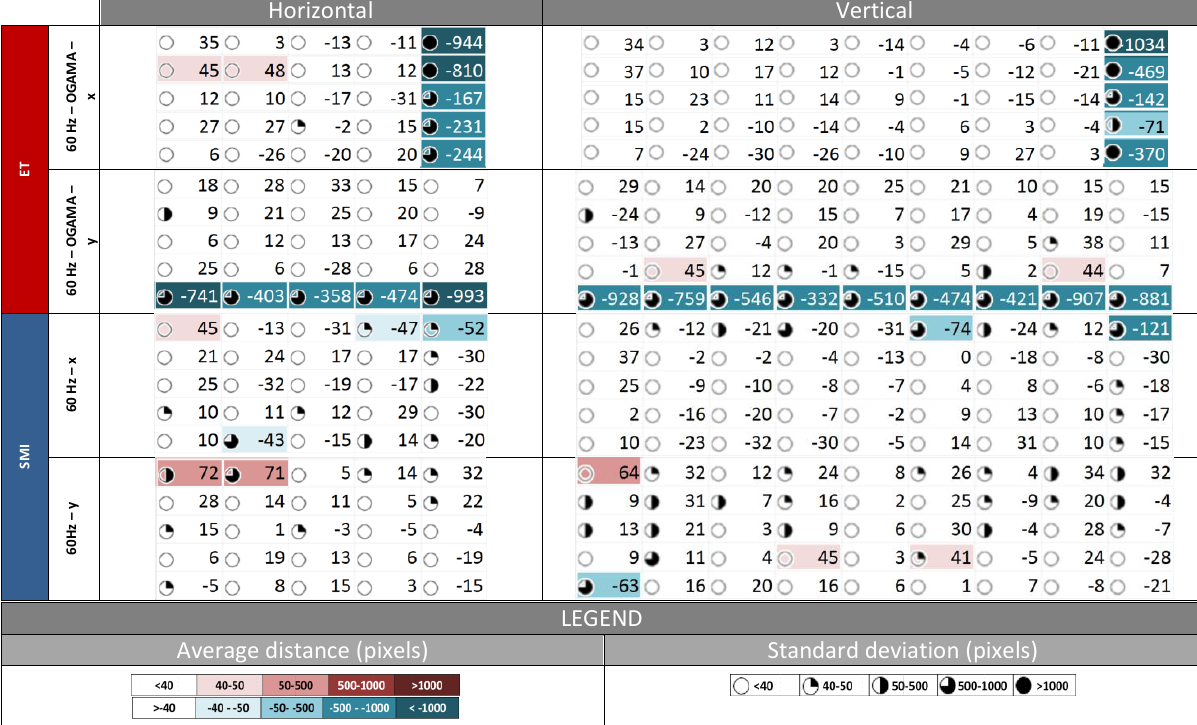
Figure 8: Average offset and standard deviation in X and Y on initial stimuli (in pixels). Offset (accuracy) values are listed on the approximate corresponding positon on the screen in a tabular layout. The color of the cells corresponds to the offset value, distinguishing between positive (red) and negative (blue) values. Similar as with the previous figures, there are five steps for each color. The standard deviation (precision) is visualized using a pie chart that is added to the corresponding cell, also using the same five